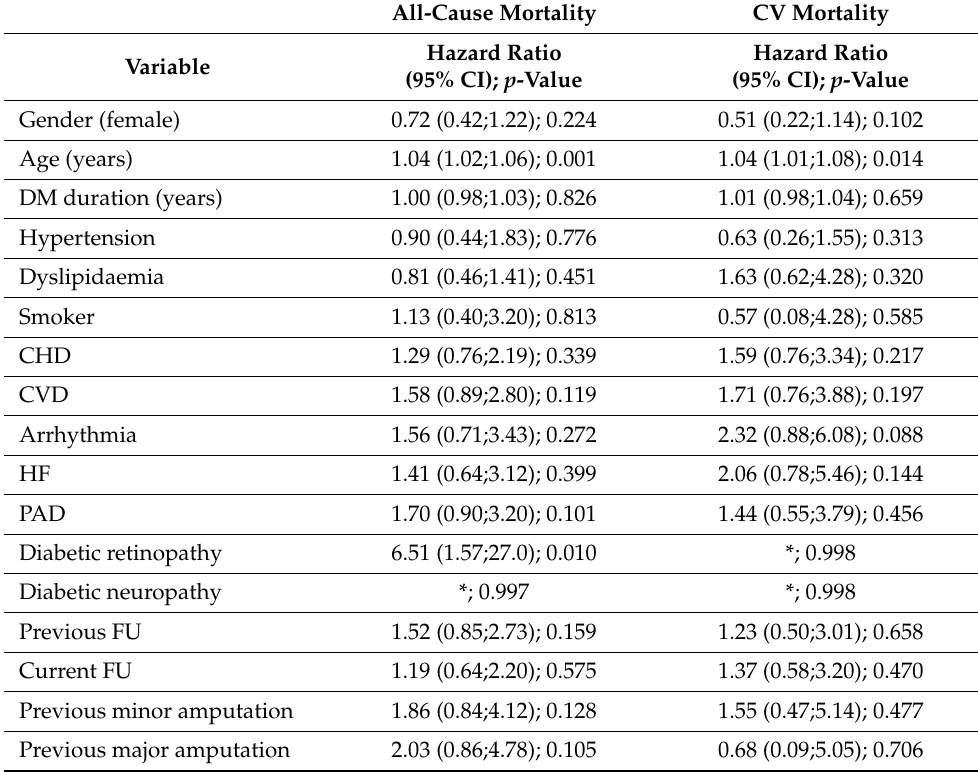
Table 3. Predictors of all-cause mortality and cardiovascular mortality in patients with diabetes mellitus ( n =